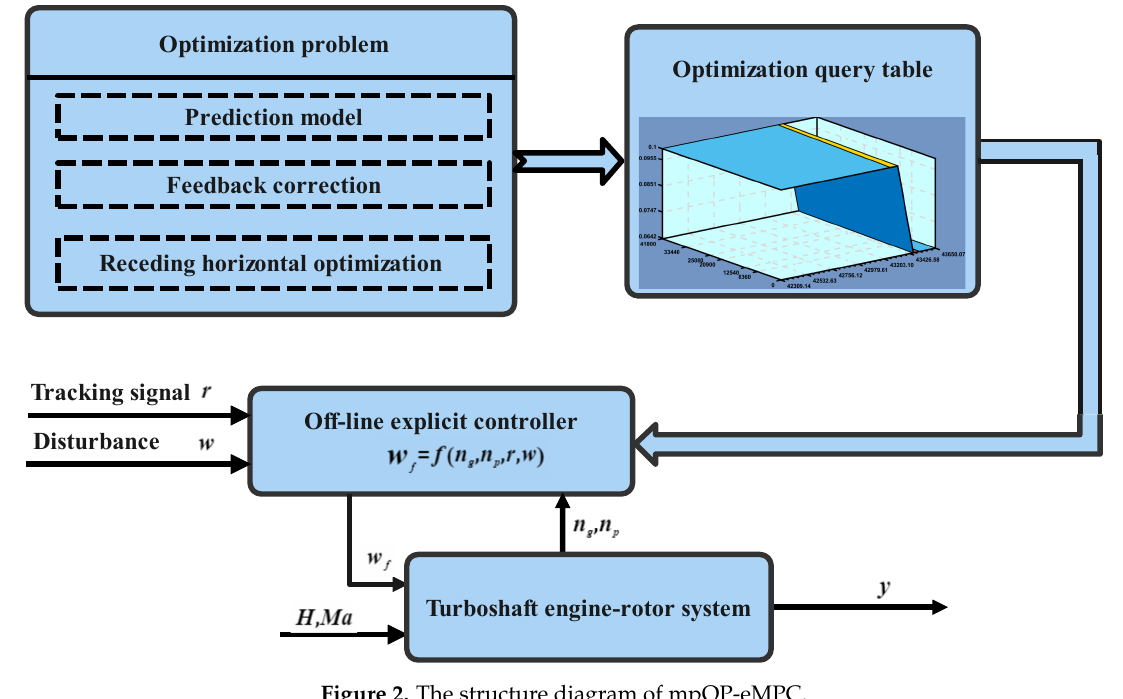
Figure 2. The structure diagram of